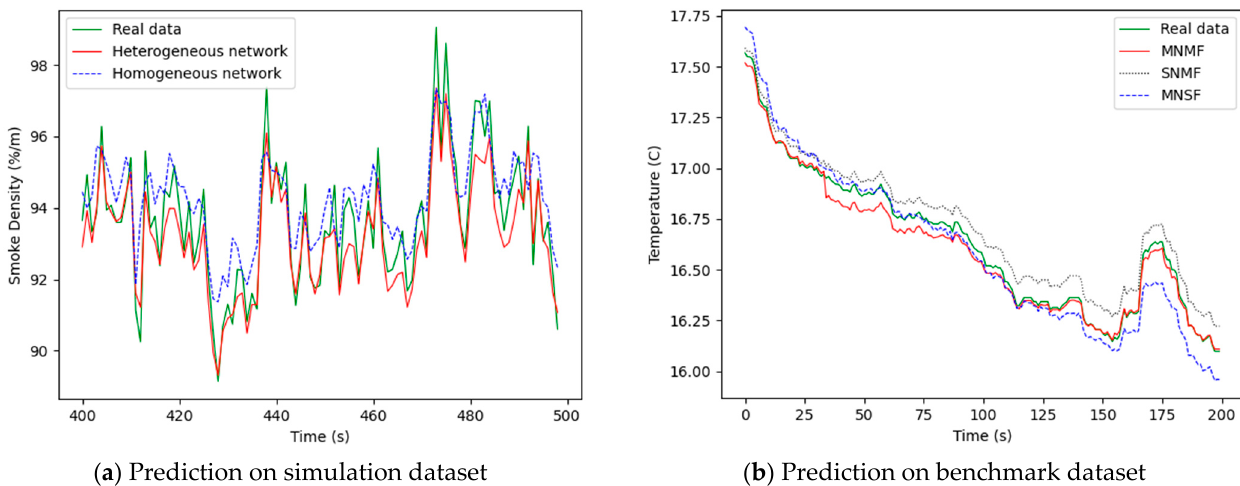
Figure 15. Prediction on two datasets. ( a ) Prediction on the simulation dataset. ( b ) Prediction on the benchmark dataset